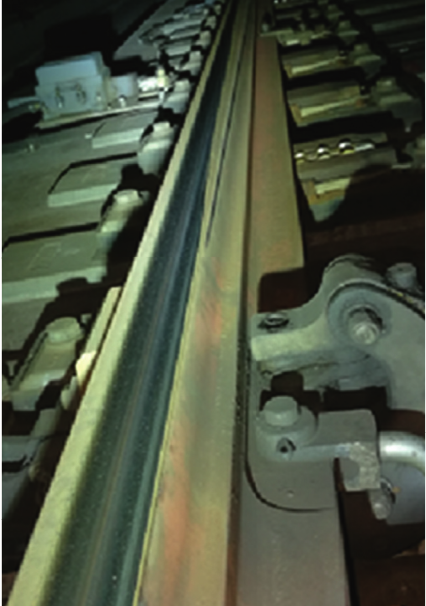
Figure 11: Photo of the rail with an oblique crack at the inner side of the railhead at the